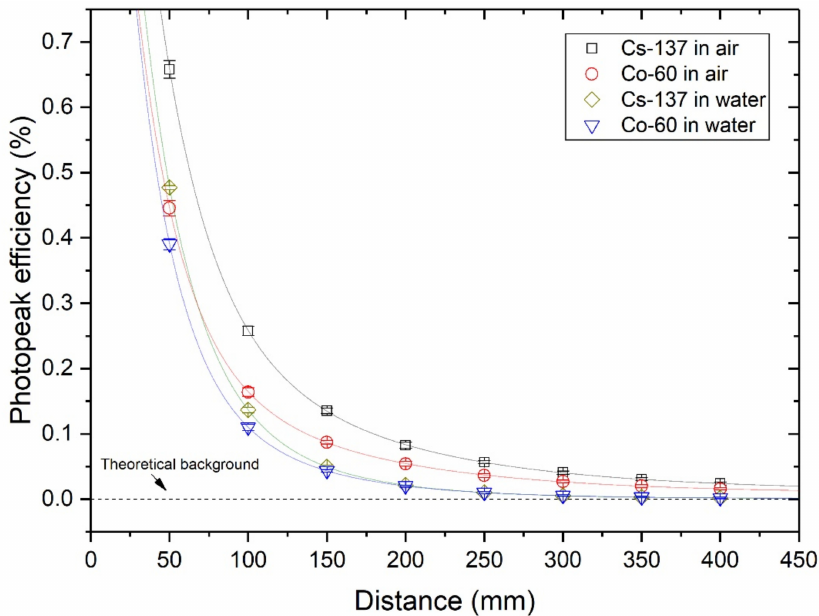
Figure 9. Photopeak efficiency for sealed sources at different distances and media.